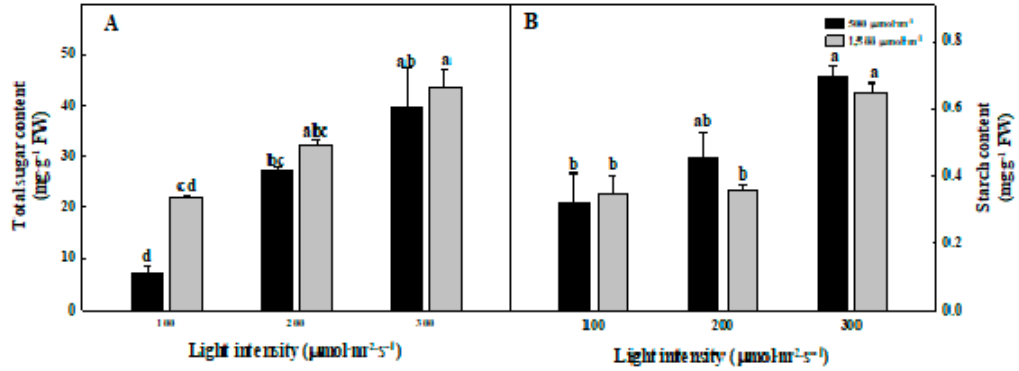
Figure 3. The different total sugar ( A ) and starch ( B ) contents of Glehnia littoralis Fr. Schmidt ex Miquel, as affected by various CO 2 concentrations and light intensities after 56 days of treatment. The vertical bars represent the standard deviation of the mean ( n = 3). Different letters above bars indicate significant differences at p ≤ 0.05, using Tukey’s multiple range test.